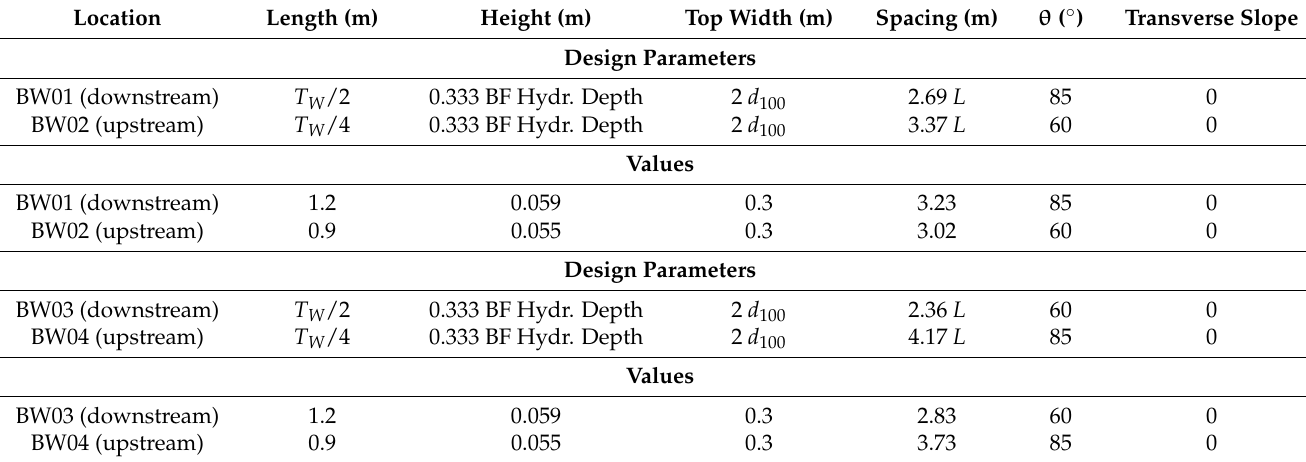
Table 3. Bendway Weir Configurations [26].